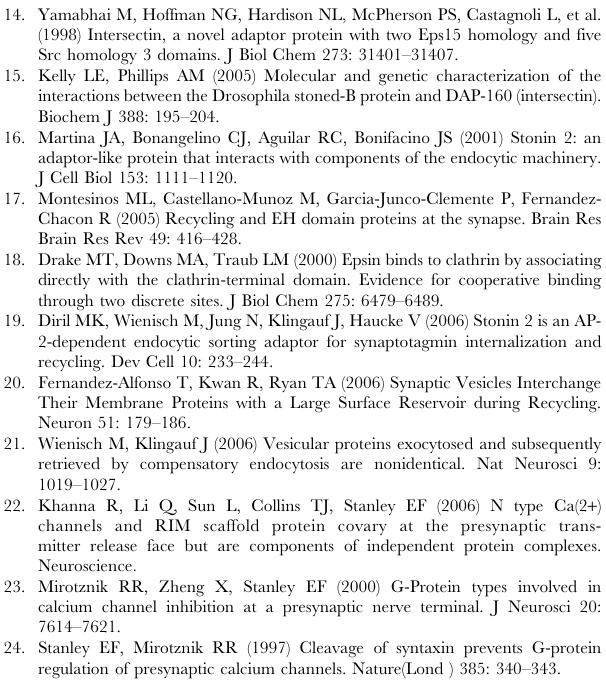
Figure S1 Calibration of protein recovery and reciprocity of immunoprecipitations. (A) Western blot analysis of a gel loaded with various amounts of rat brain synaptosomes at concentration between 1.25 and 30 mg and immunoblotted for synaptotagmin (STG). (B) Plot of band intensity against amount of protein loaded.